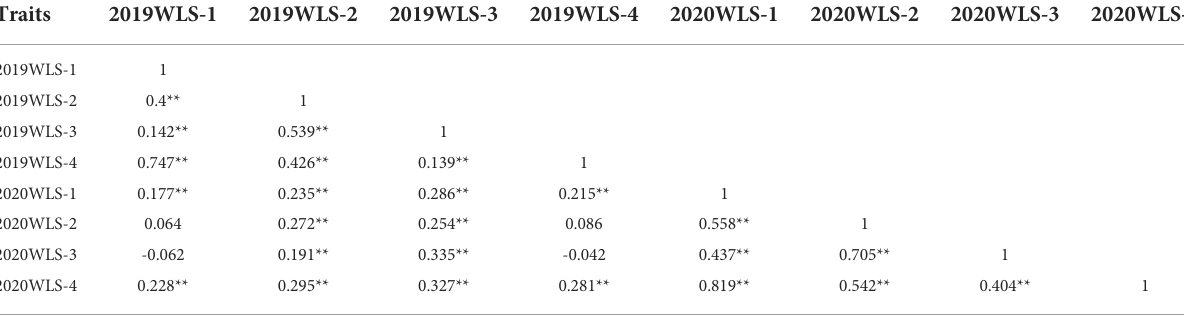
TABLE 2 Correlation analysis of waterlogging score at different